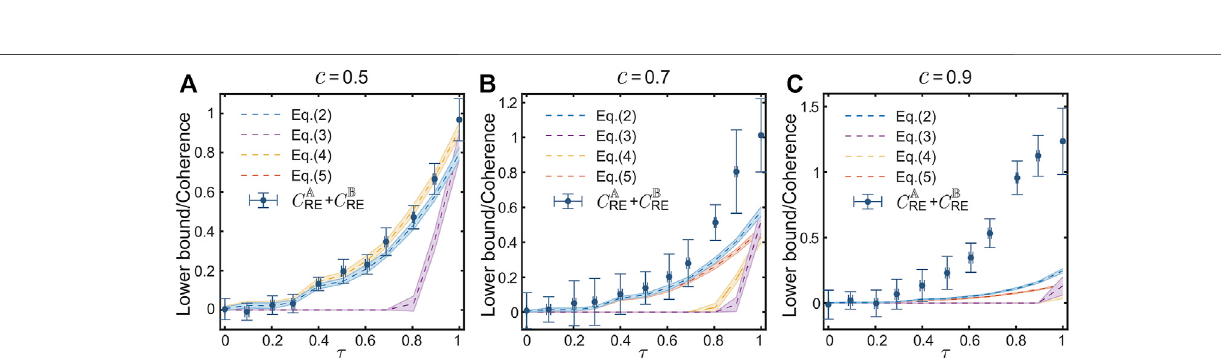
FIGURE4 | Results ofQURs in Eqs2 – 5 on 11 prepared states with (A) c = 0.5, (B) c = 0.7, and (C) c = 0.9. Thedashed lines arethe measured lower bounds and the shadow area represents the statistical error by repeating CS measurement for 20 times.